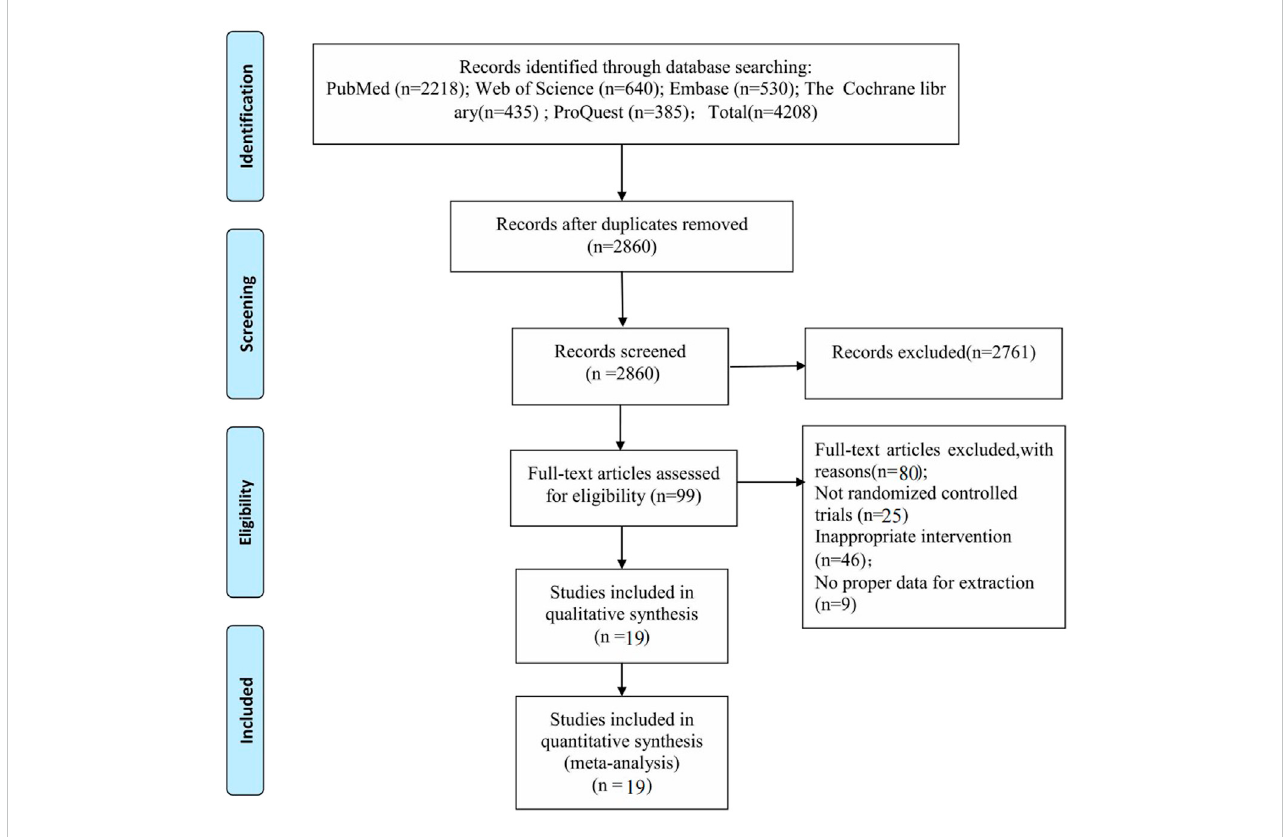
FIGURE 1 Flowchart of the study selection